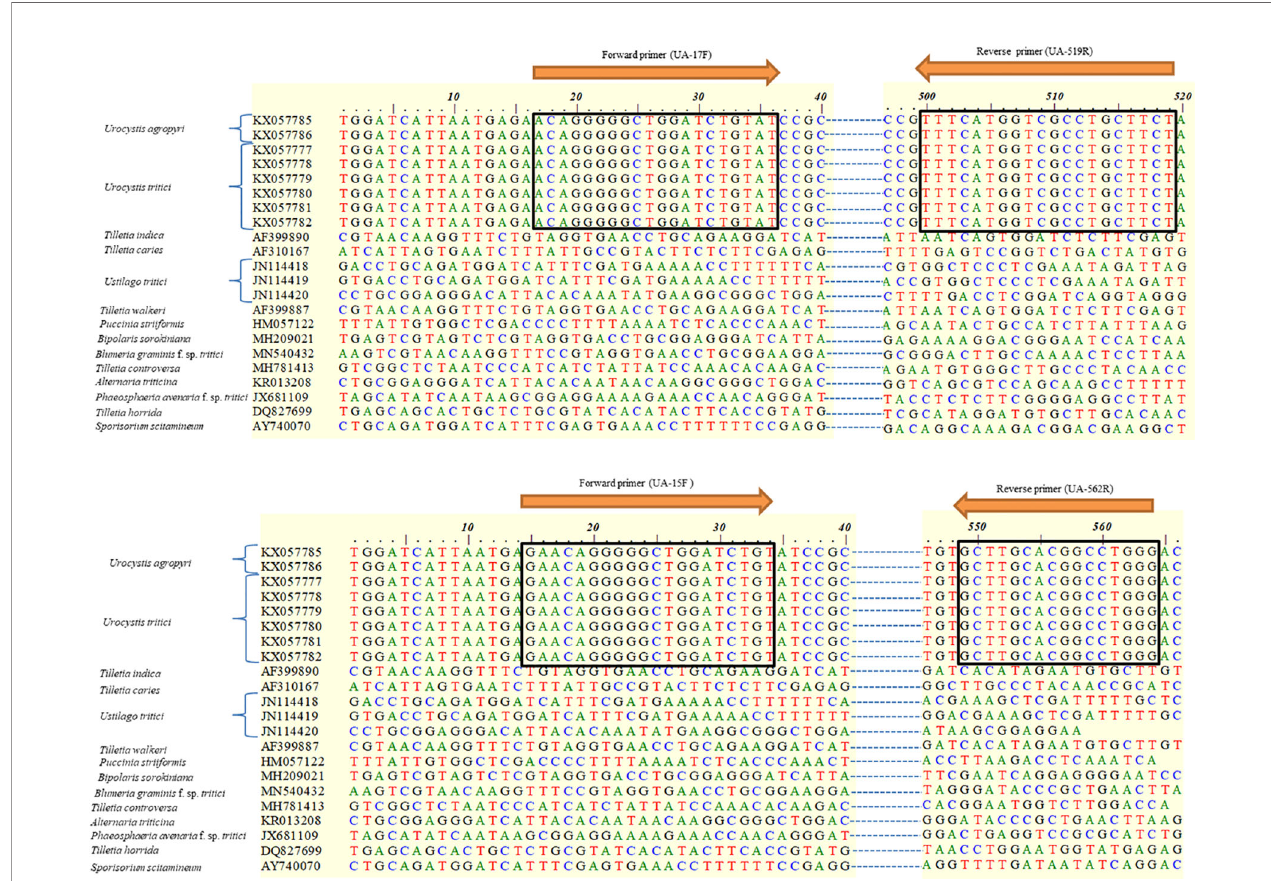
FIGURE 1 | Alignment of consensus sequences of internal transcribed spacer (ITS) regions of the ribosomal DNA (rDNA) used for selecting diagnostic primers which are indicated in box. Numbers on the top refer to nucleotide positions of NCBI GenBank accession KX057786. The two arrows indicate the forward (UA-17F and UA-15F) and reverse (UA-519R and UA-562R) primers identi fi ed for the ampli fi cation of U. agropyri speci fi c DNA. The speci fi city of the designed primer sets was indicated by making in silico comparison with the nonredundant (nr) sequences from other fungal pathogens ( Tilletia indica , T. caries , Ustilago tritici , T. walkeri ,